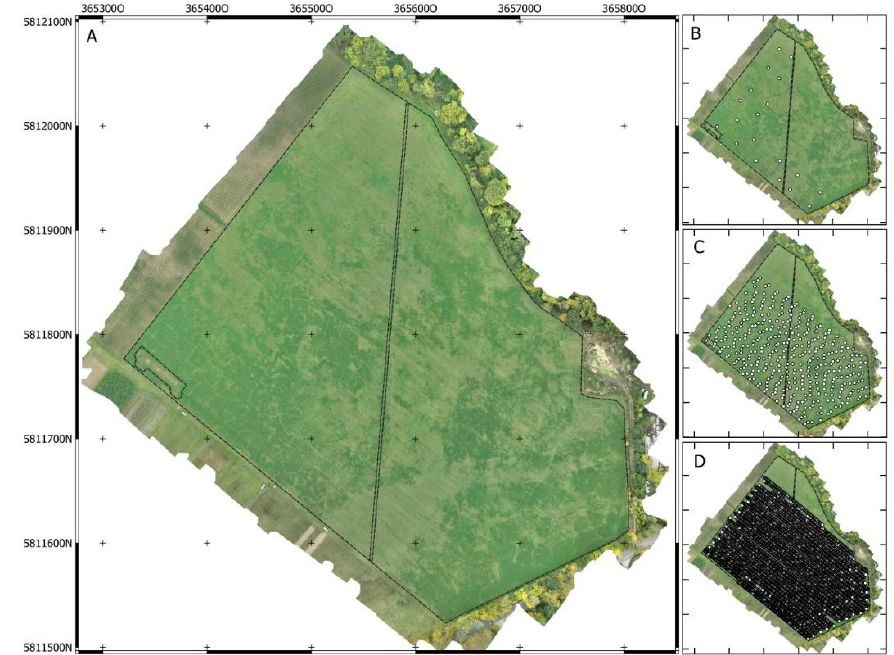
Figure 1. Unmanned aerial vehicles (UAV)-based orthophoto of ( A ) the Königsfeld with the locations of ( B ) biomass sampling sites, ( C ) sensor-based pH, and ( D ) apparent electrical conductivity (ECa) measurements.